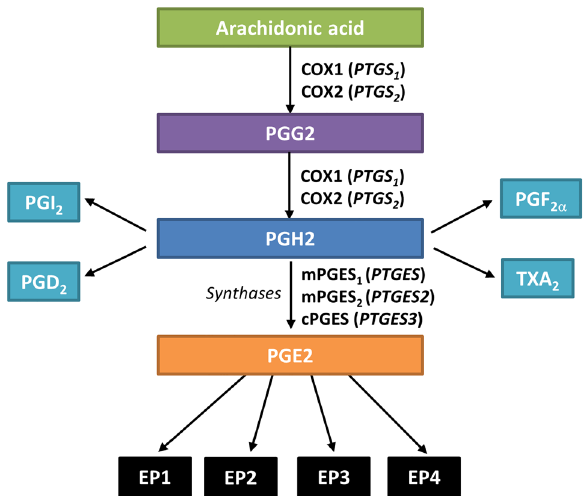
Figure 1. Overview of the cyclooxygenase-PGE2 pathway. Gene names are shown in